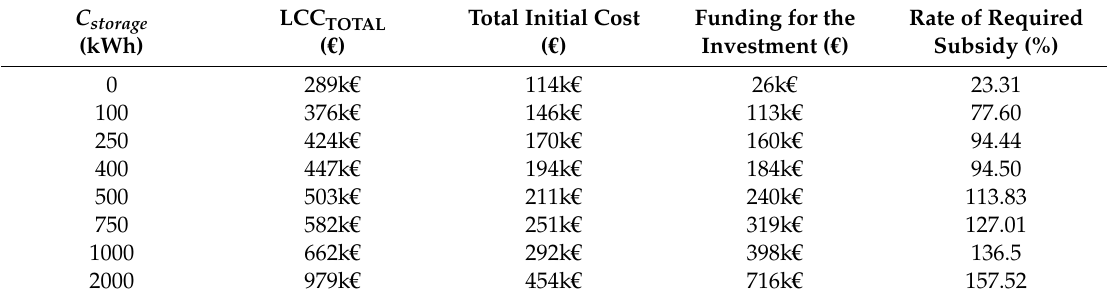
Table 6. LCCA of the whole investment for each scenario of EESU